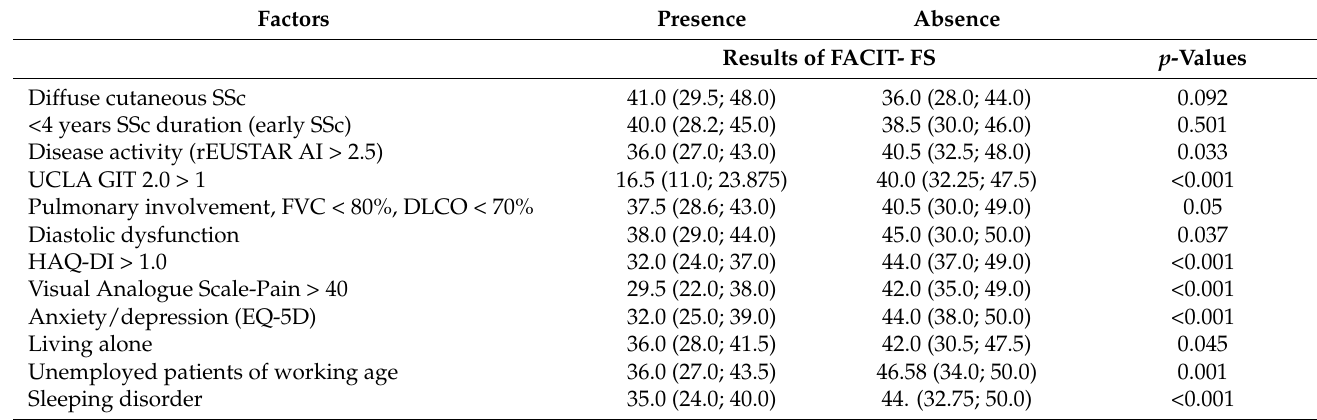
Table 3. Comparing fatigue symptoms based on the results of the Functional Assessment of Chronic Illness Therapy-Fatigue Scale (FACIT-FS) between different subgroups of 160 patients with systemic sclerosis